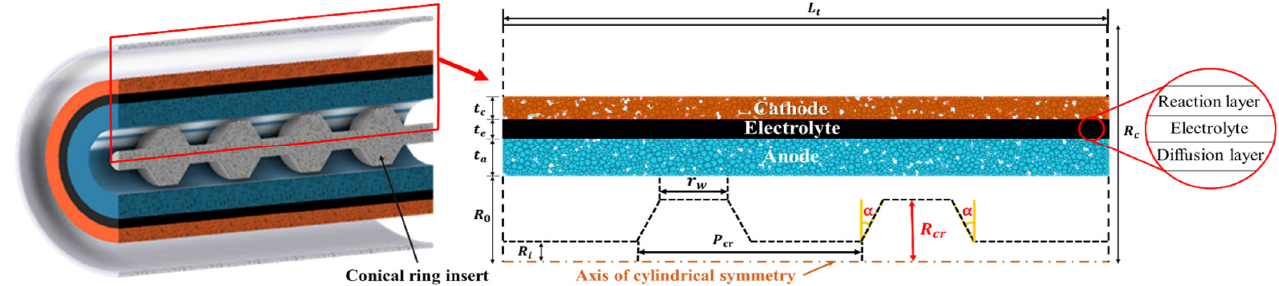
Figure 1. Schematic of a tubular solid oxide fuel cell with a convergent conical ring insert.